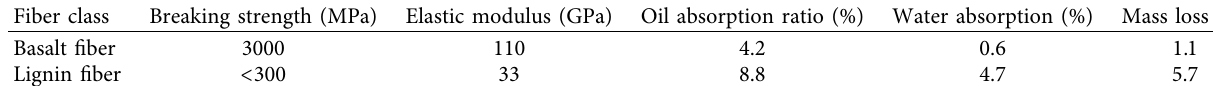
Table 5: Technical specifications for different types of fibers.